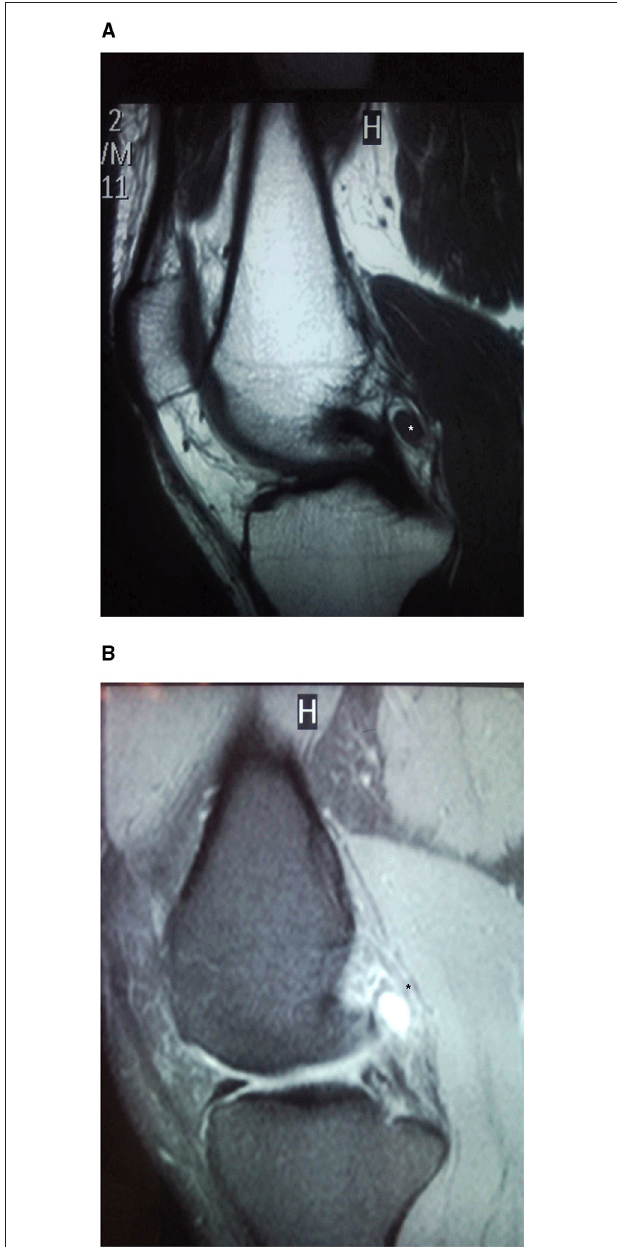
FIGURE 7 | Case 4: posterior compartment SH MRI. Sagittal MRI sequences showing a well-defined intra-articular synovial mass in the posterior compartment of the knee, behind the PCL. On T1-weighted (A) sequences, the mass was isointense to the surrounding muscle with peripheral heterogeneous areas; the mass was hyperintense on T2-weighted images (B) . *Location of the Synovial Haemangioma tumor in the knee.